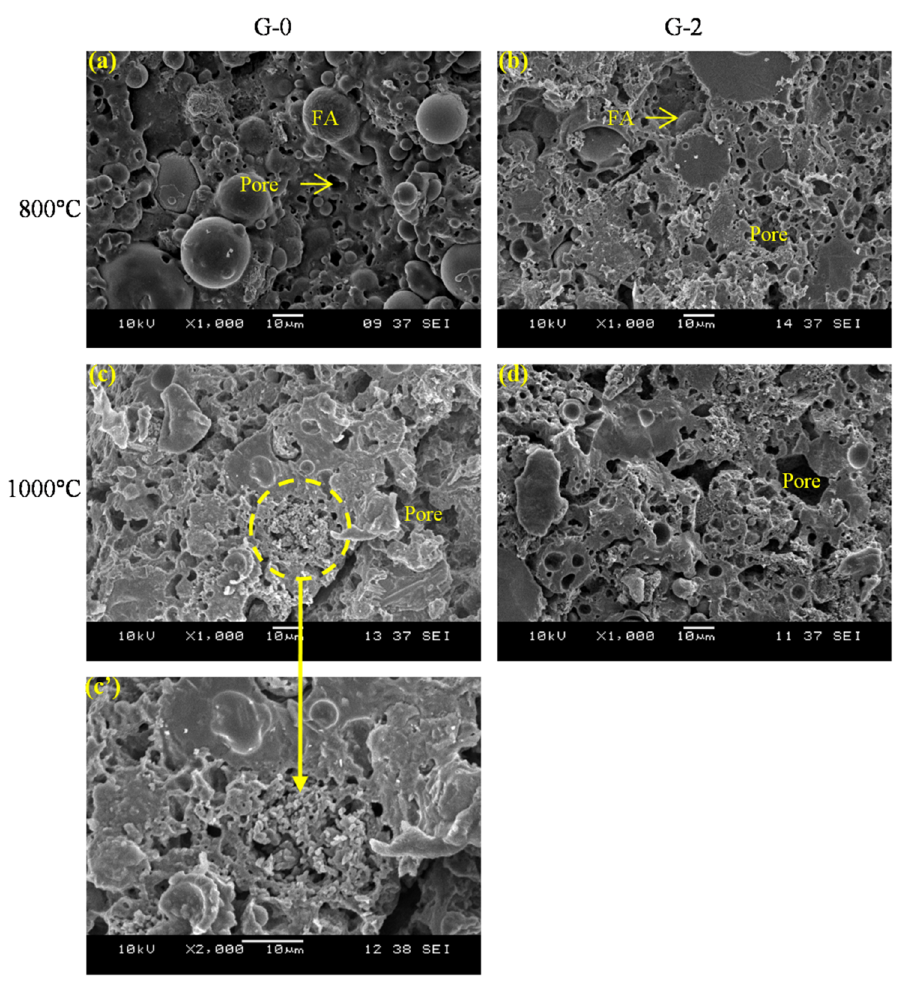
Figure 11. SEM images of G-0 and G-2 after exposed to ( a , b ) 800 °C and ( c , c’ , d ) 1000 °C (FA denoted fly ash).